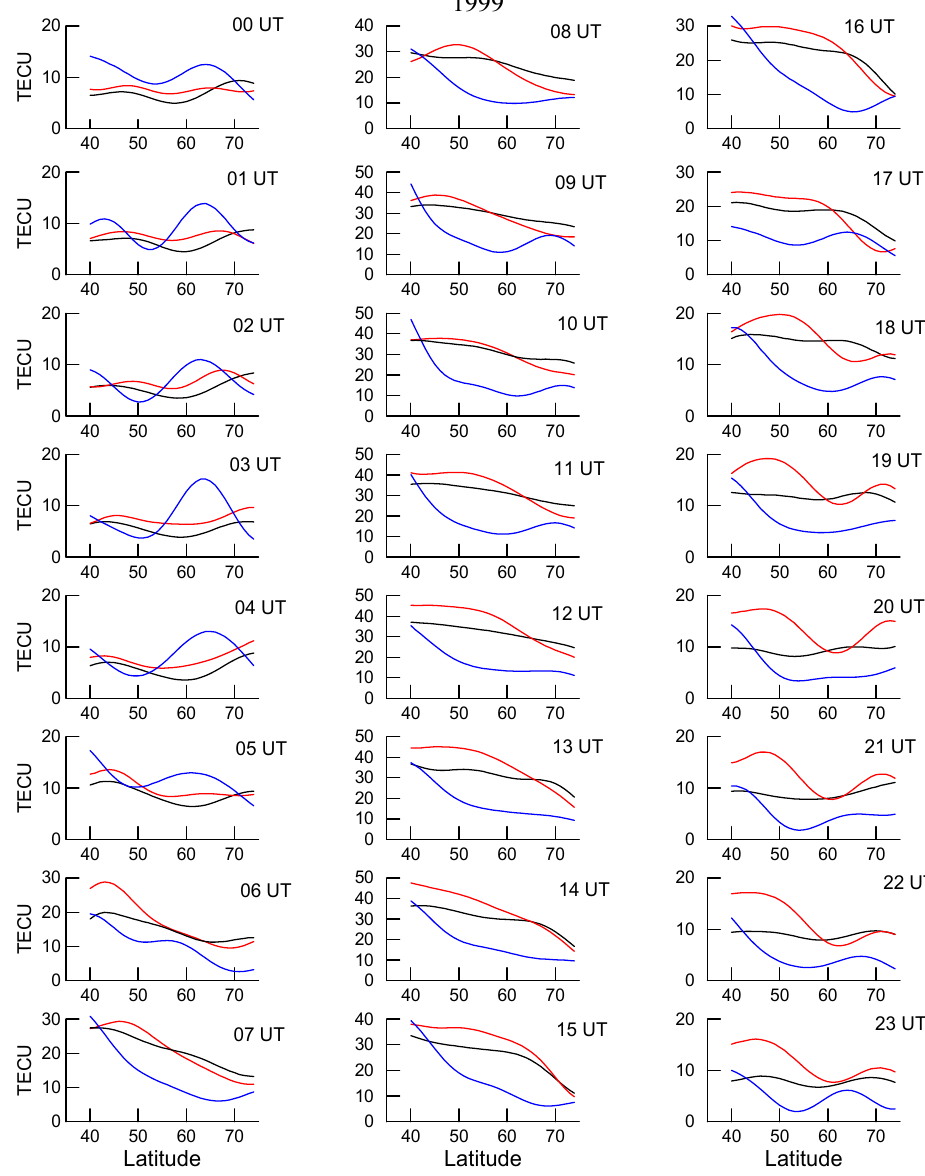
Fig.4 Latitudinal TEC profiles over Europe at longitude 20o E. Black line – 20 October, ∑ Kp=6, Fig. 4. Latitudinal TEC profiles over Europe at longitude 20 ◦ E. Black line – 20 October, P K p = 6, red line – 21 October, P K p = 25, red line – 21 October, ∑ Kp=25, blue line – 22 October, ∑ Kp=46. blue line – 22 October, P K p =